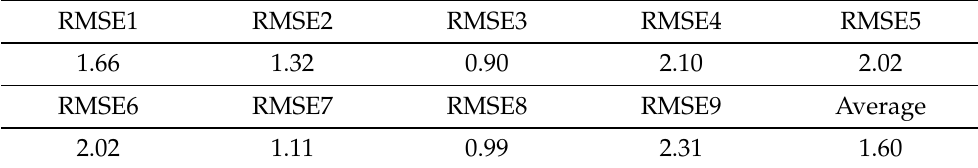
Table 3. RMSE values of the prediction (same dataset).